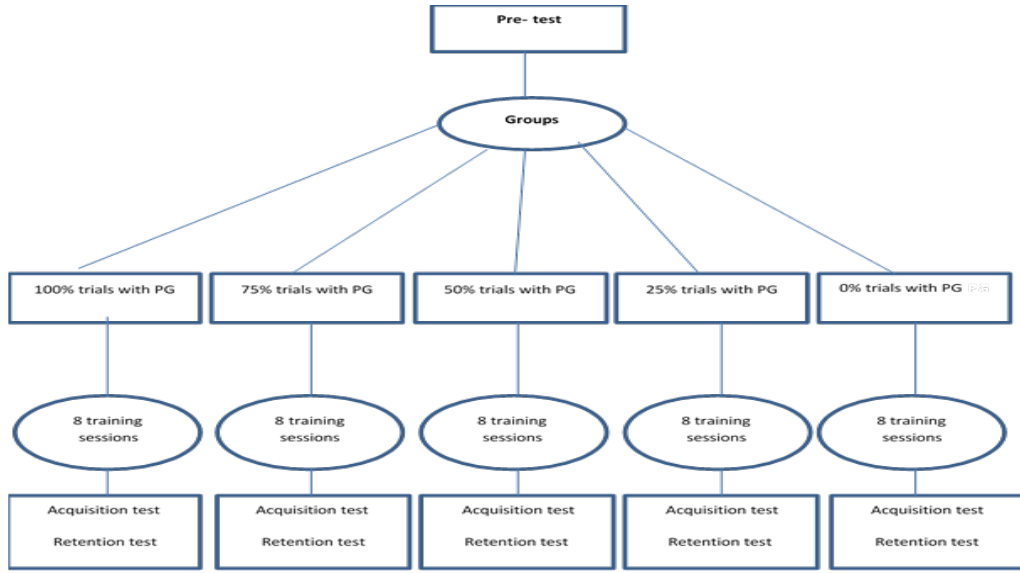
Figure 2. Research design.